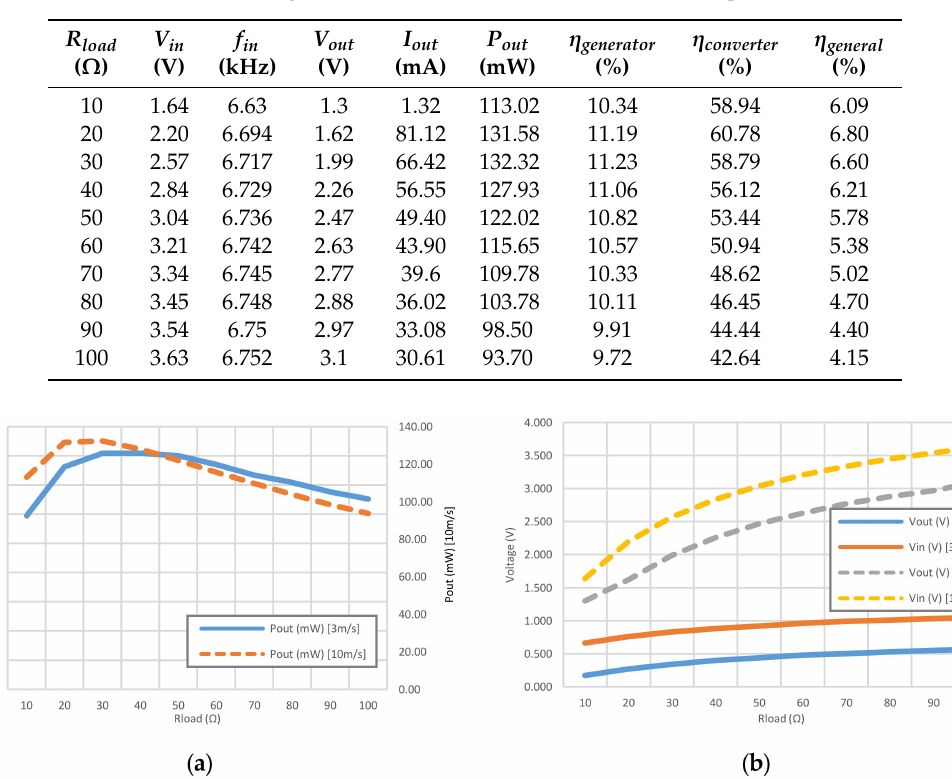
Table 22. Diode bridge simulation results under the maximum input condition.